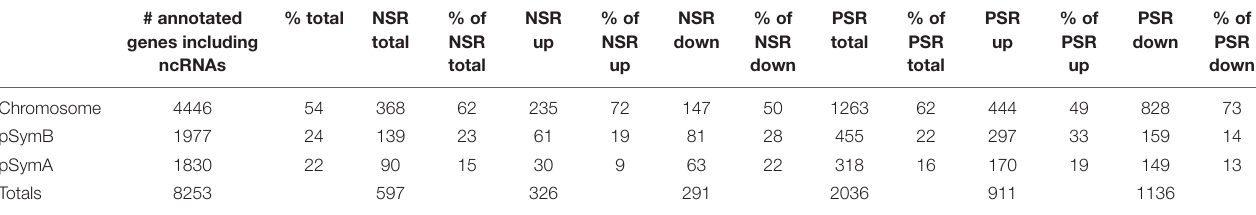
TABLE 1 | Distribution of Nitrogen and Phosphate responsive genes on the S. meliloti replicons. # annotated genes